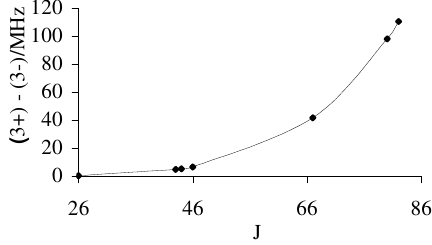
Figure 2. Variation of K = 3 splitting with J.